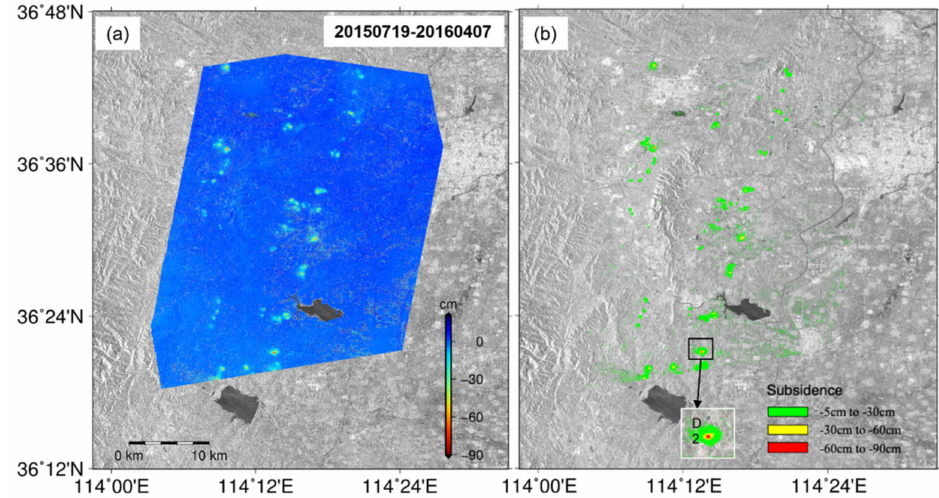
Figure 12. ( a ) Vertical deformation of the Fengfeng mining area from 20150719 to 20160407. ( b ) The subsidence of mining sites larger than 5 cm.